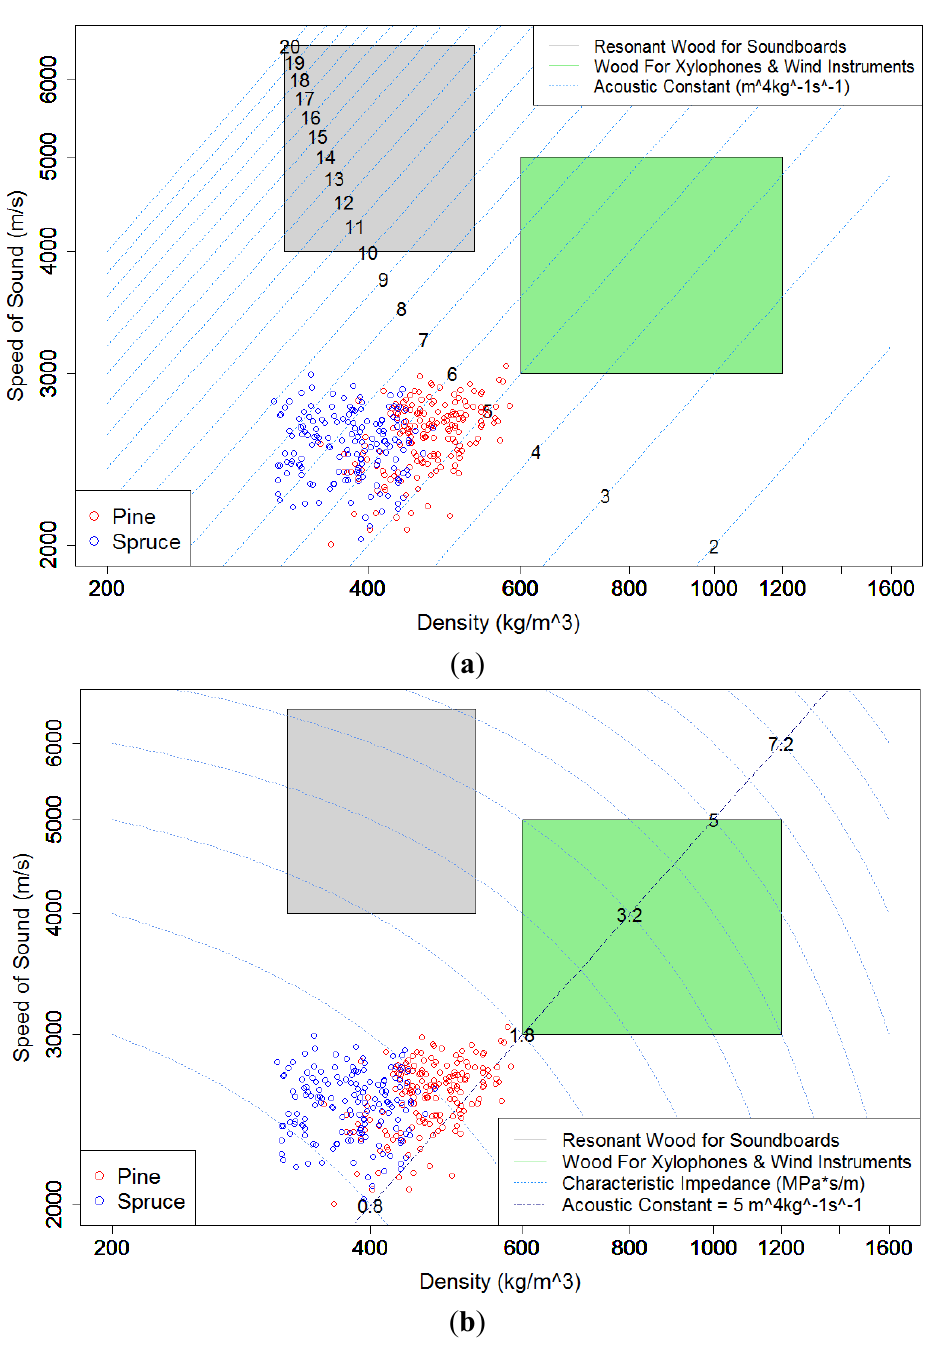
Figure 1. Speed vs. density scatterplot with acoustic constant ( a ) and with impedance ( b ). Note: logarithmic